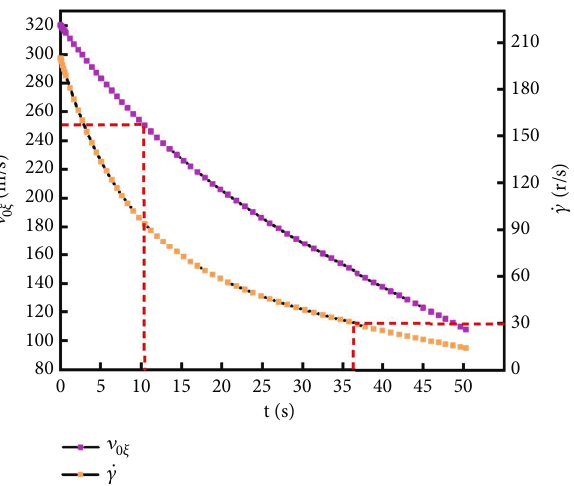
Figure 8: The change curves of the angular velocity and the fl ight velocity in the direction of the projectile ’ s